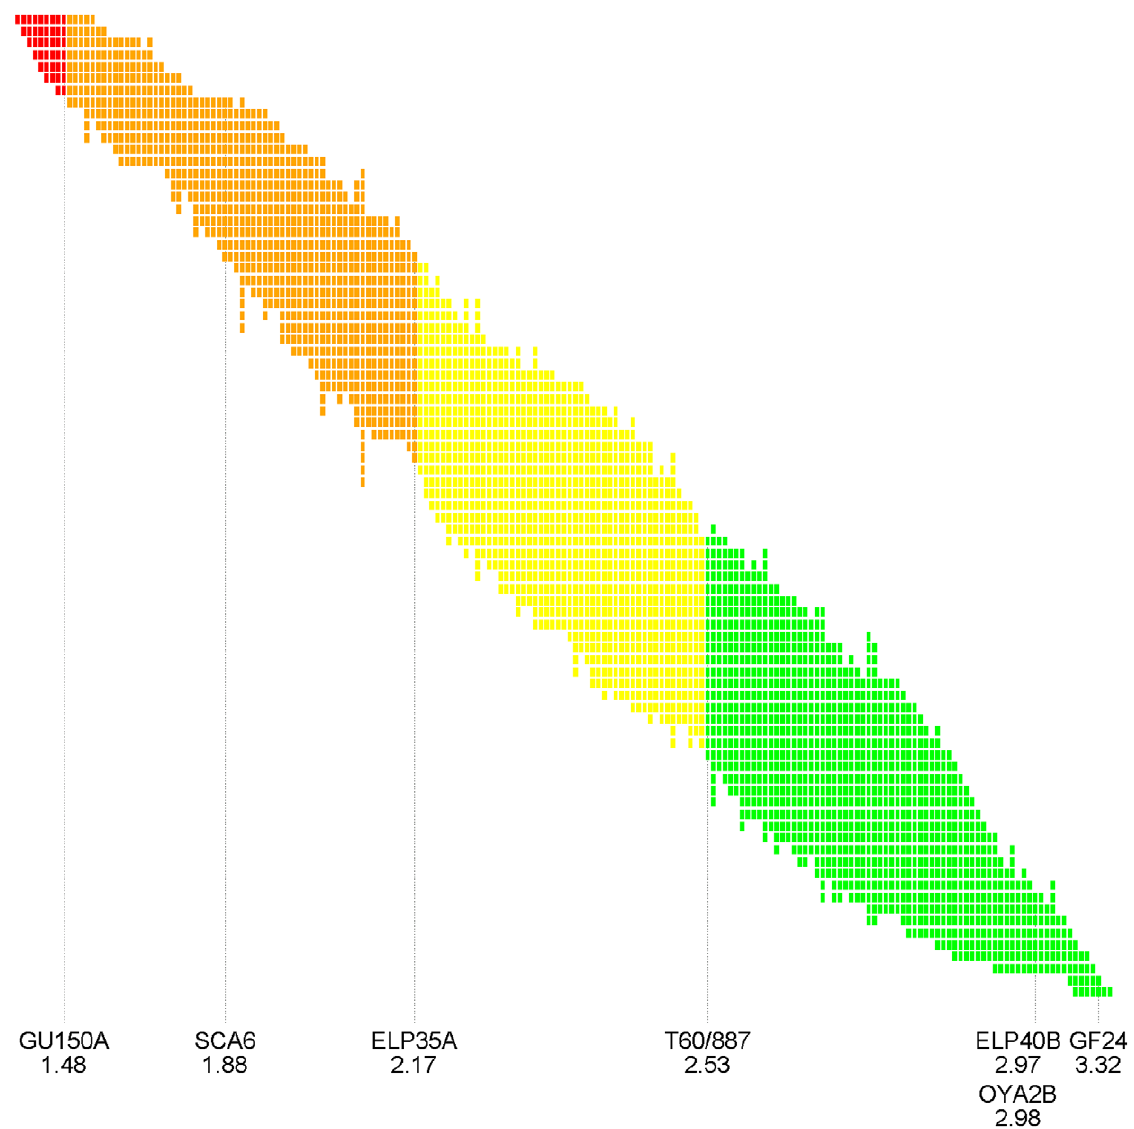
Figure 1. Cross-representation of the clones and homogeneity groups. Each column corresponds to a clone and each row to a homogeneity group. Four statistically different groups are represented, from left to right: very resistant clones = more resistant than SCA6 (red); resistant clones = equivalent to SCA 6 (orange); moderately resistant clones = less resistant than SCA6, but more resistant than ELP 40-B (yellow); susceptible clones = not different from ELP 40-B (green). The clones indicated, with their average score, are the controls (SCA 6, ELP 40-B, OYA 2-B, GF 24) and those on the edge of groups (GU 150-A, ELP 35-A, T60/887).